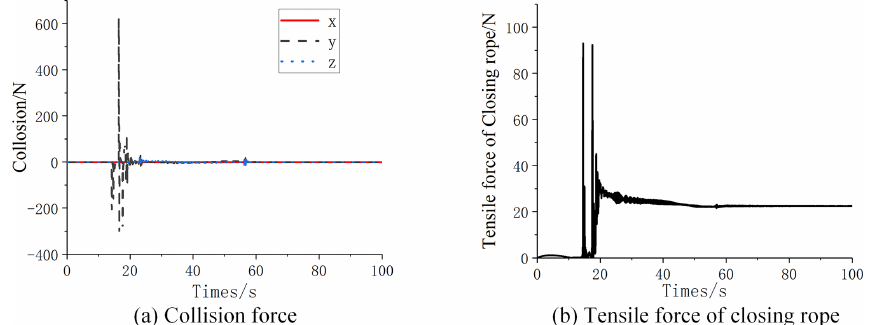
Figure 11. Service spacecraft attitude dynamic